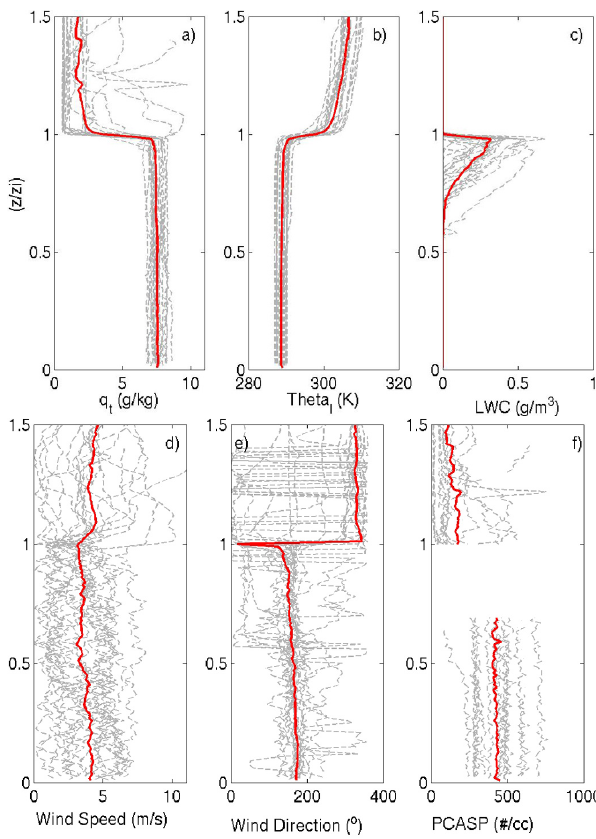
Fig. 6. Profiles scaled by the PBL heights. (a) total-water mixing ratio (gkg − 1 ) ; (b) liquid water potential temperature (K); (c) LWC (gm − 3 ) ; (d) wind speed (ms − 1 ) ; (e) wind direction (degree), and (f) N a from PCASP (#cm − 3 ) for all 18 flights. The gray lines indi- cate all individual flights, and the red solid lines show the composite soundings.